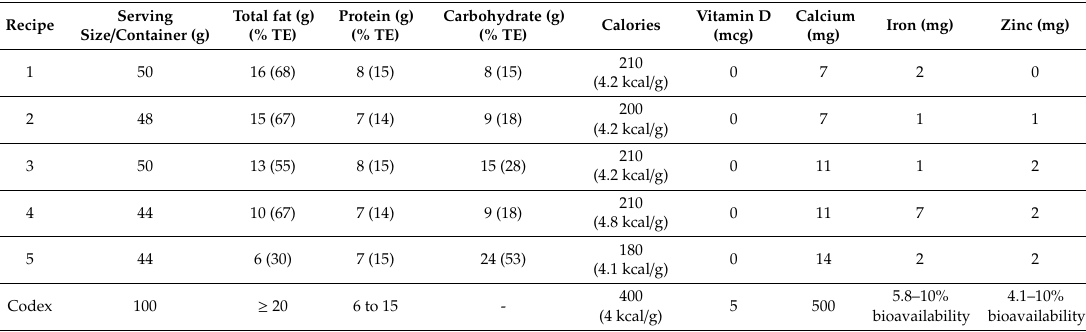
Table 7. Summary of the five developed recipes (food labels) as generated by the ESHA Food Processor. Recipe